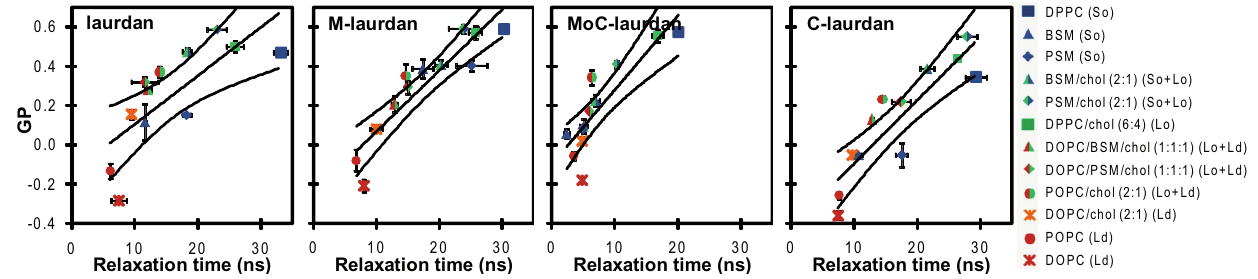
Figure 7. Correlation graphs between GP and relaxation time for laurdan, M-laurdan, MoC-laurdan and C-laurdan in various model membranes at room temperature (color codes reported from Figure 2–Figure 4). Experiments were performed twice and reported values are mean ± SD (unseen error bars are below the size of symbols). Superimposed lanes are linear regressions and 95% confidence bands. The correlation coefficient is the best for M-laurdan (0.83), good for C-laurdan (0.79) and MoC-laurdan (0.75) and moderate for laurdan (0.57). Beyond the coefficient of correlation, M-laurdan is the only probe for which pure sphingomyelins (BSM and PSM) are measured close to DPPC, reporting most accurately for bilayers in solid order phase at room temperature.